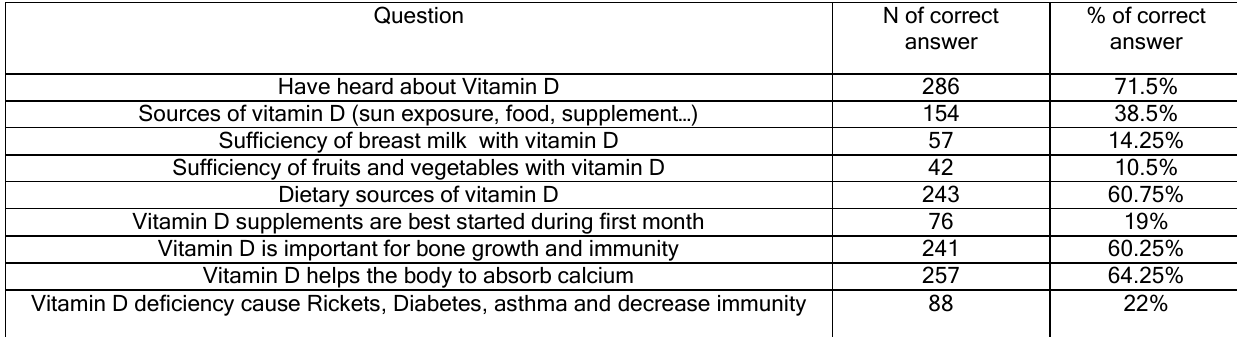
Table 2: Participant’s responses towards knowledge questions (N=400)